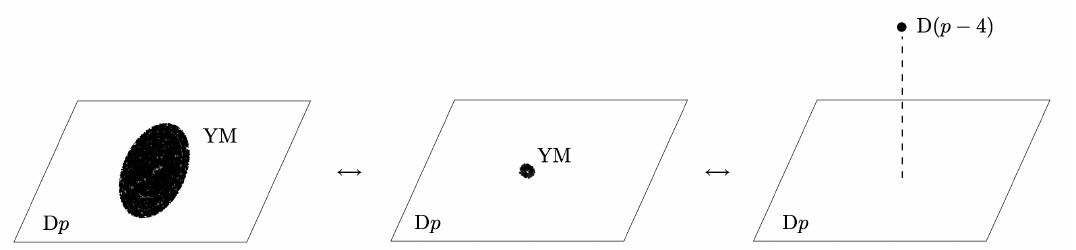
Figure 3 . Illustration of the process that converts between a Yang-Mills instanton localized on a stack of D p -branes (depicted at left) and a D ( p − 4) -brane that can move freely into the bulk (depicted at right). The instanton solution has a size modulus, and small instantons are indis- tinguishable from lower-dimensional D-branes. As a result, instanton charge and D ( p − 4) -brane charge are not independently conserved, avoiding a global